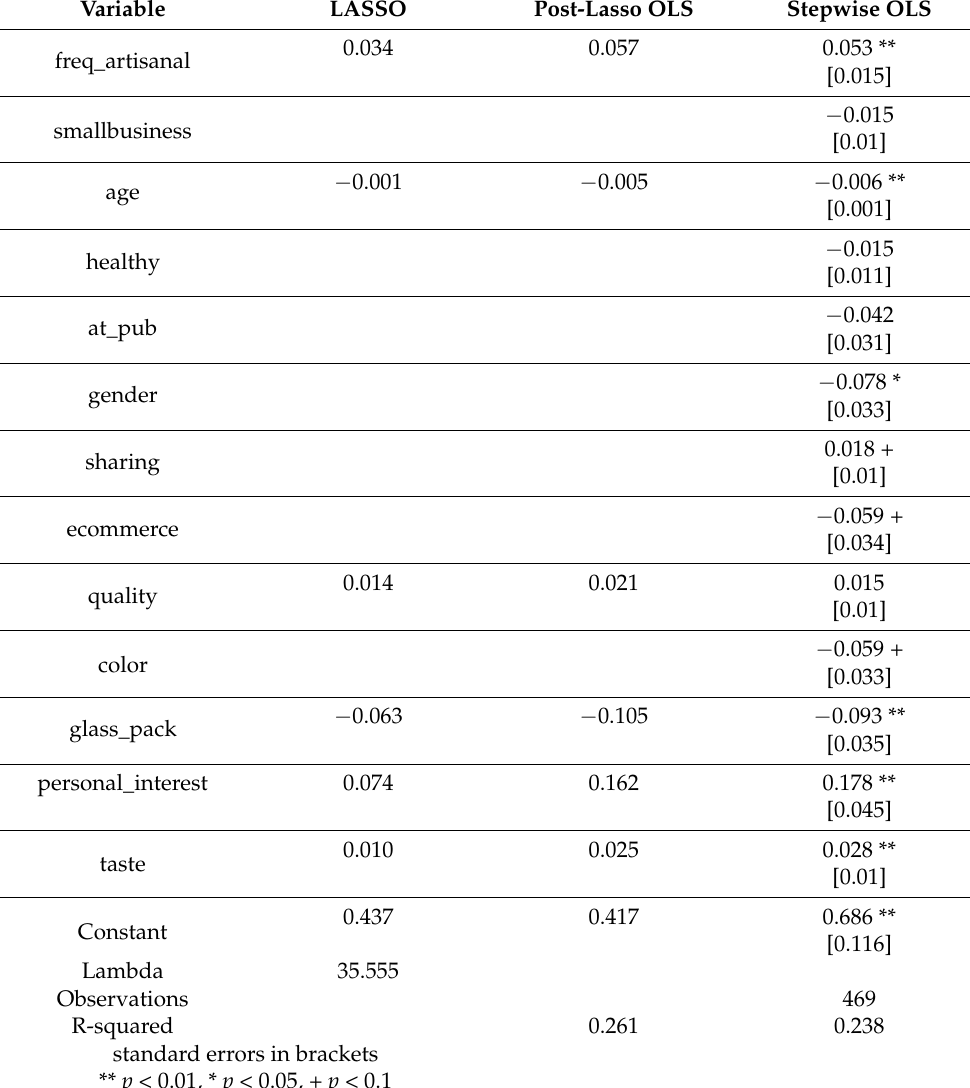
Table 6. Results from the stepwise OLS regression and post-lasso OLS regression analyses.